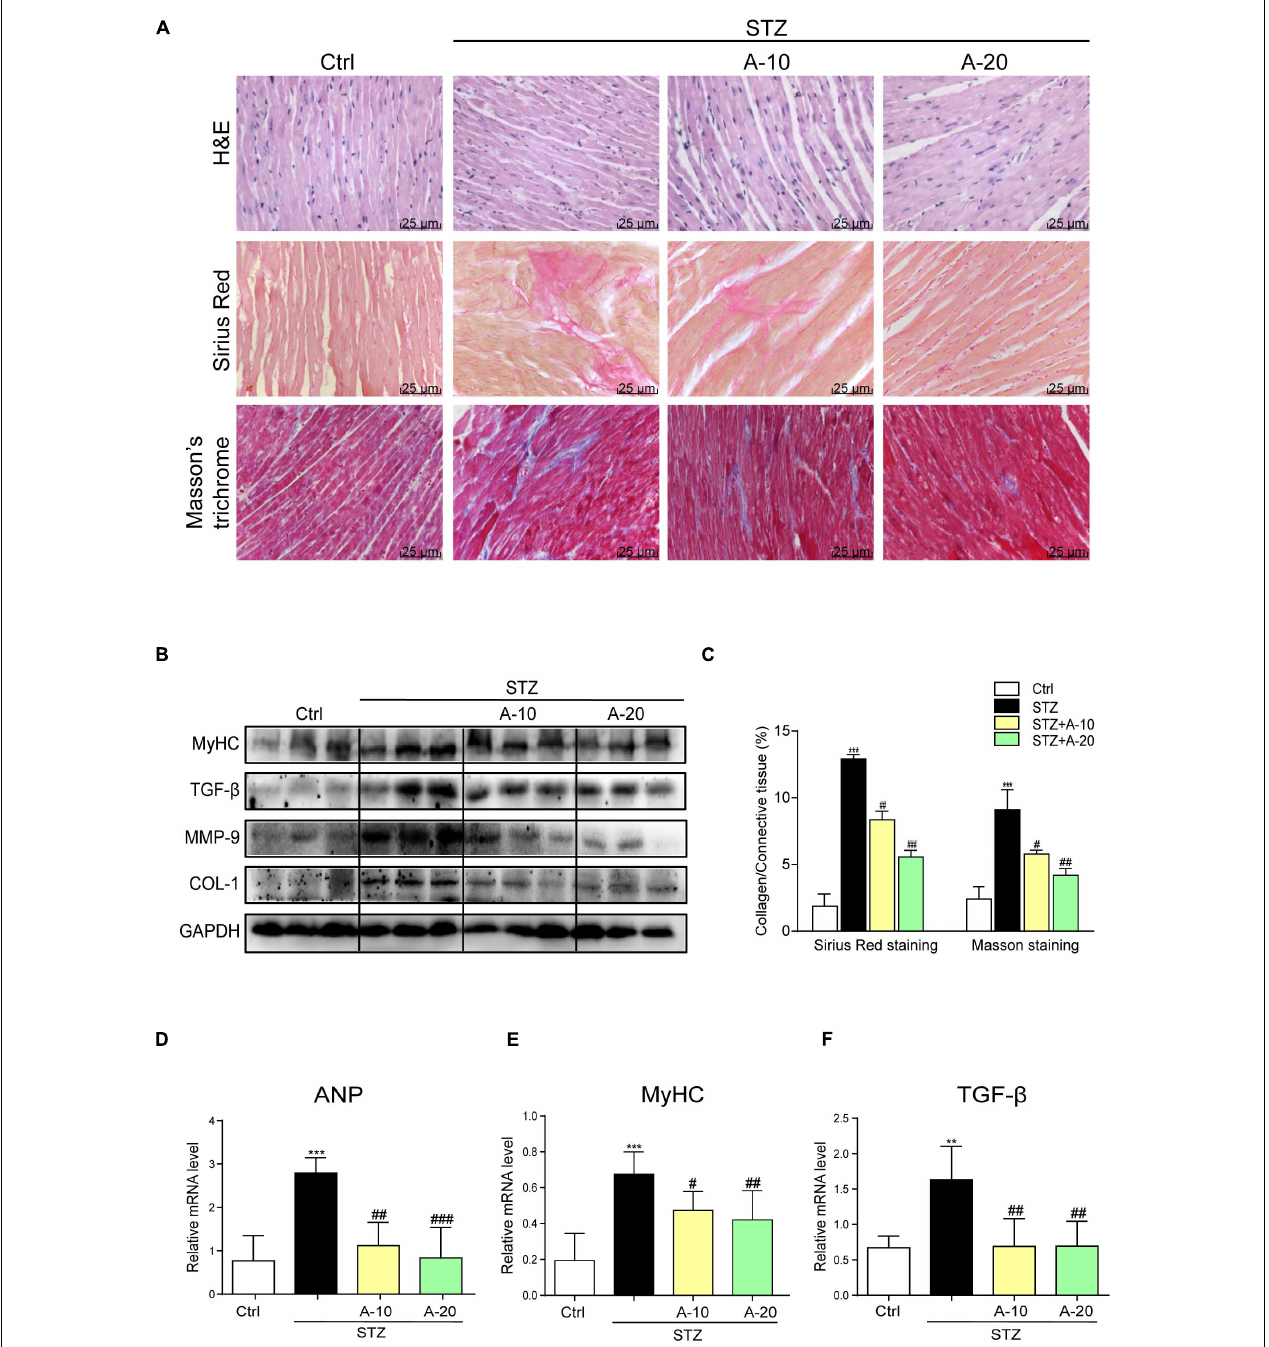
FIGURE 2 | Blockade of the P2X7 receptor attenuated STZ-induced cardiac remodeling. Representative images of hematoxylin-eosin staining (H&E) of the myocardial tissues (400 × magnification), ( A , upper panel). Myocardial fibrosis analysis was detected using Sirius Red staining ( A , middle panel), and representative images of Masson’s trichrome staining ( A , bottom panel) are shown (400 × magnification). Bar graph showing the quantified interstitial fibrotic areas (%) in images of Sirius Red staining and Masson’s trichrome staining (C) . Levels of the MyHC, TGF- β , MMP-9, and COL-1 proteins in myocardial tissues were measured using western blotting (B) ( n = 3 per group). The mRNA expression of the hypertrophy markers MyHC and ANP (D,E) and fibrosis marker TGF- β (F) in the myocardial tissues is shown (data from three independent experiments were analyzed: * p < 0.05, ** p < 0.01, and *** p < 0.001 compared with the Ctrl; # p < 0.05, ## p < 0.01, and ### p < 0.001 compared with STZ